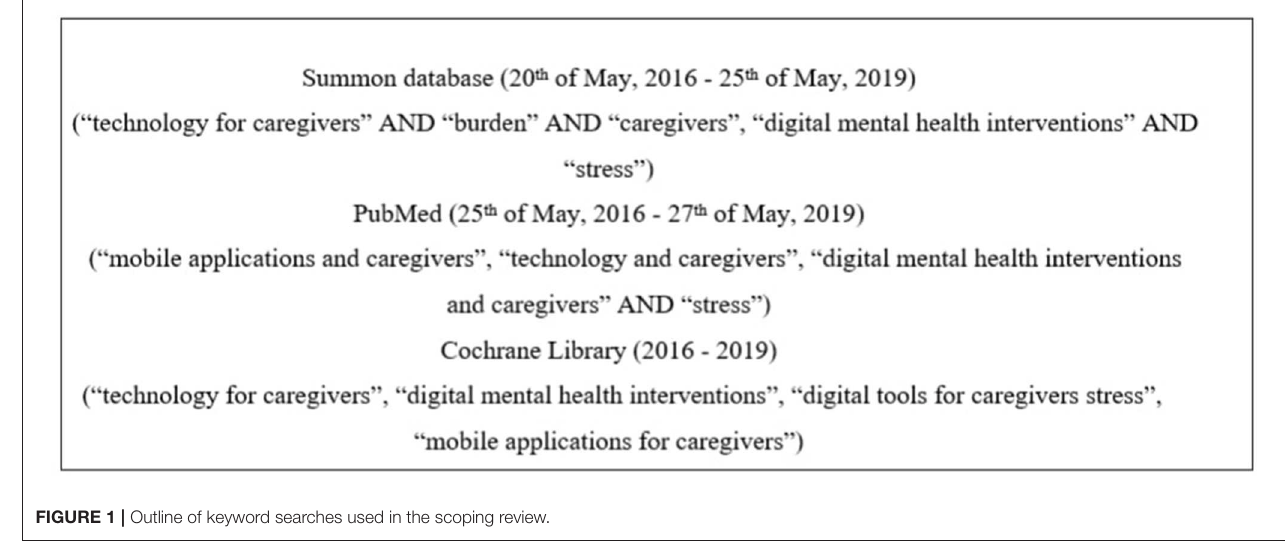
FIGURE 1 | Outline of keyword searches used in the scoping review.